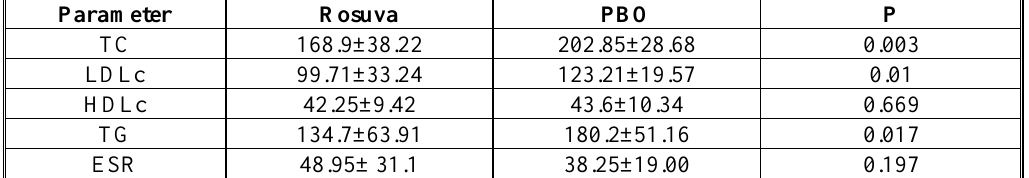
Table (3) Difference in baseline laboratory parameters between RA patients in rosuvastatin and placebo group Parameter